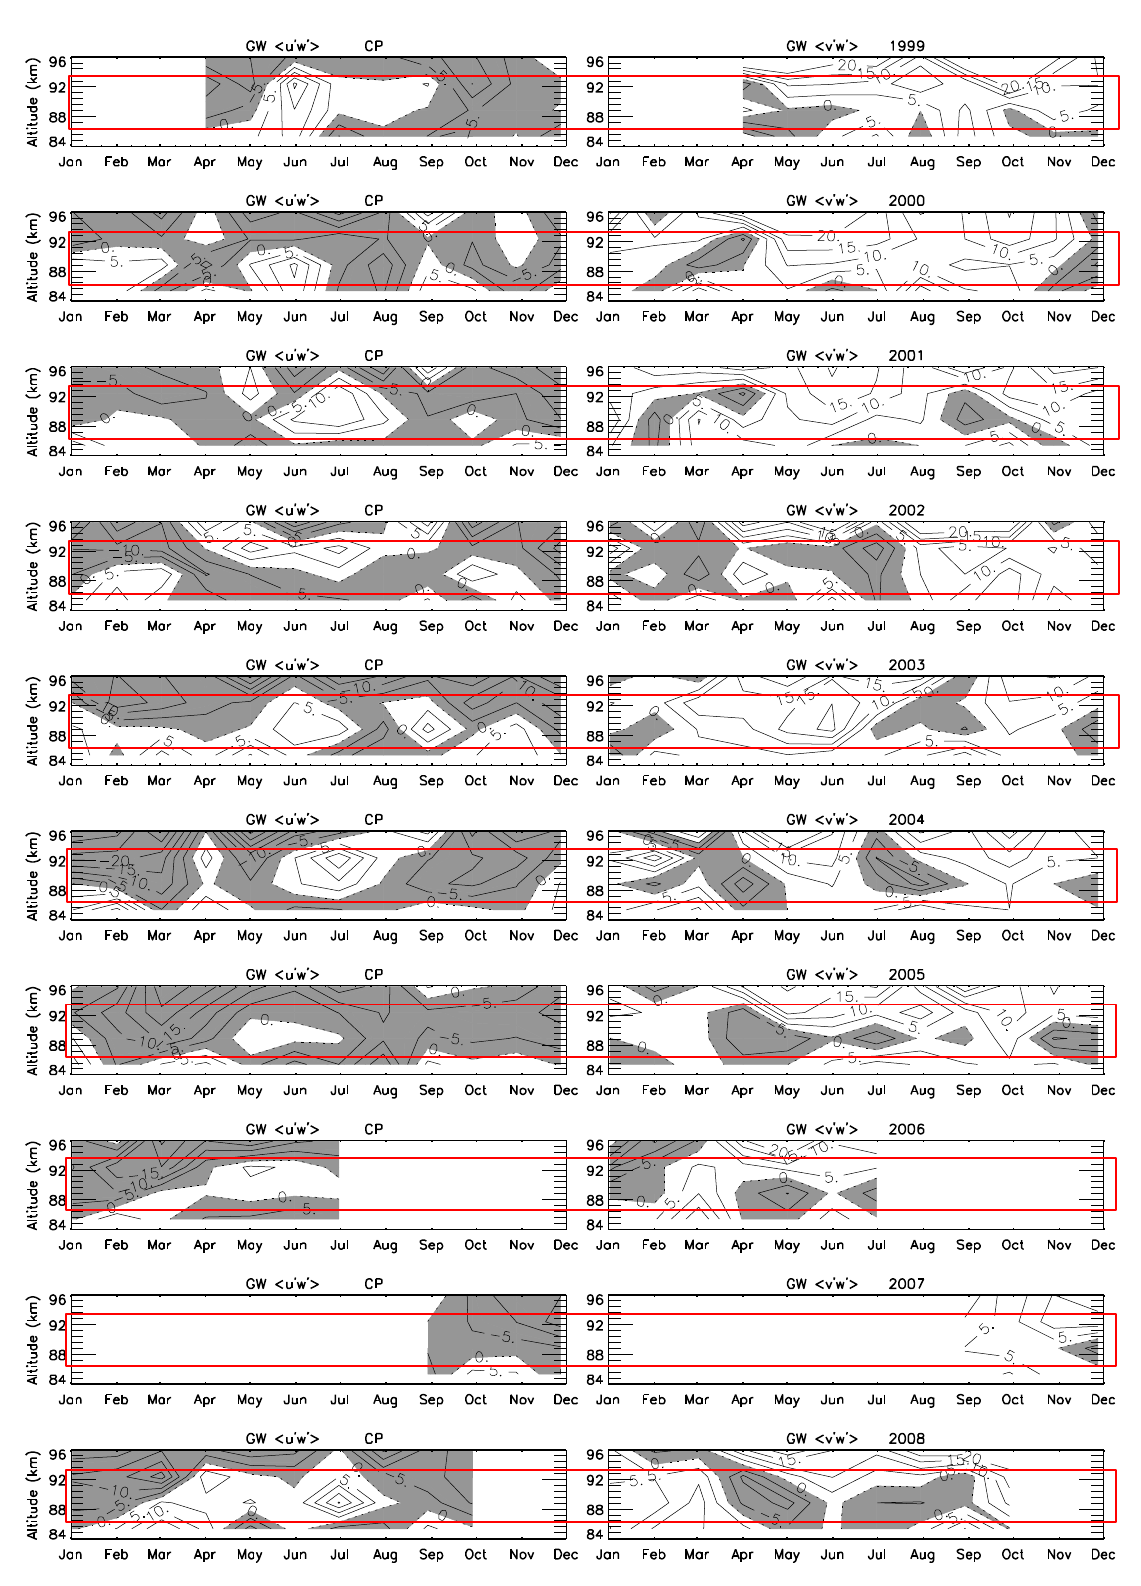
Figure 2. The same as Fig. 1 but for Cachoeira Paulista from 1999 to